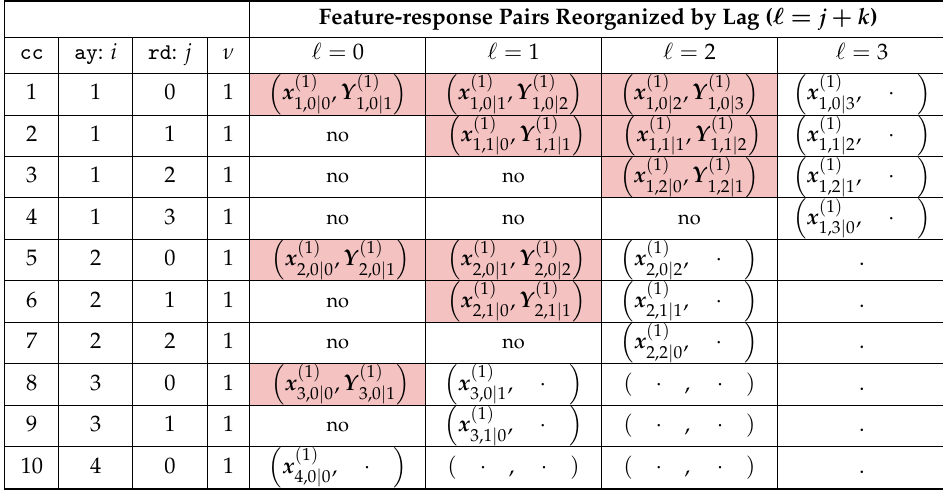
Table 2. Pairs feature-response observed at time I = 4 organized by lag. Data on last column and row 4 cannot be used for